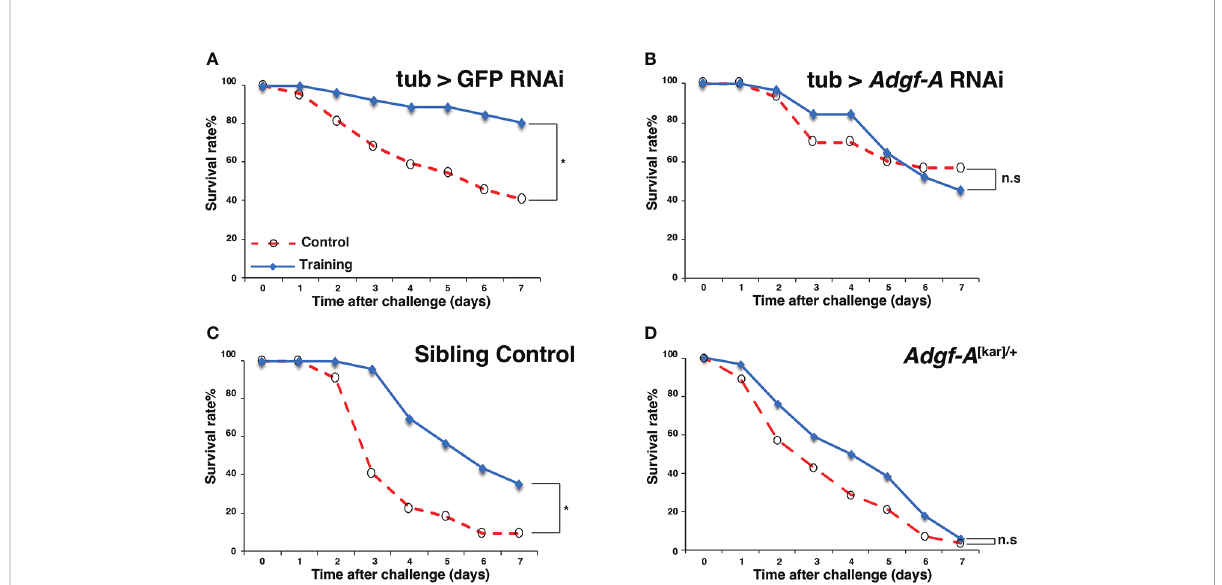
FIGURE 7 Involvement of Adgf-A in training effects. Survival curves of fl ies subjected to Ml training and Sa challenge. Blue and red lines represent survival rates under training and control conditions, respectively. (A) Control RNAi line (tub > GFP RNAi, training with Ml, OD = 2), (B) Adgf-A RNAi line (tub > Adgf-A RNAi, training with Ml, OD = 2), and (C) Sibling control ( Adgf-A +/+ ) of (D) , (D) Adgf-A mutant heterozygote ( Adgf-A [kar]/+ ). *, p < 0.05; n.s., not signi fi cant, determined using the log-rank test. The numbers of fl ies used in these experiments were (A) 22, 26, (B) 30, 31 (C) 22, 23, (D) 28, 34 (under training or control conditions,